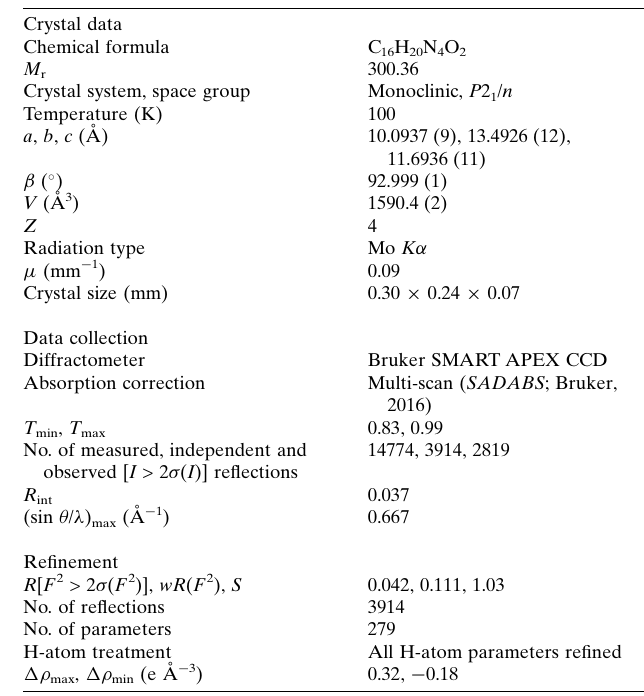
Table 1 Hydrogen-bond geometry (A˚ , (cid:2) ).